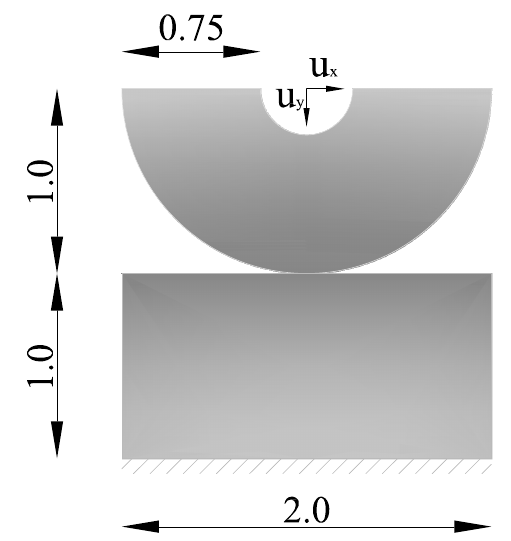
Figure 6: Ironing problem scheme.